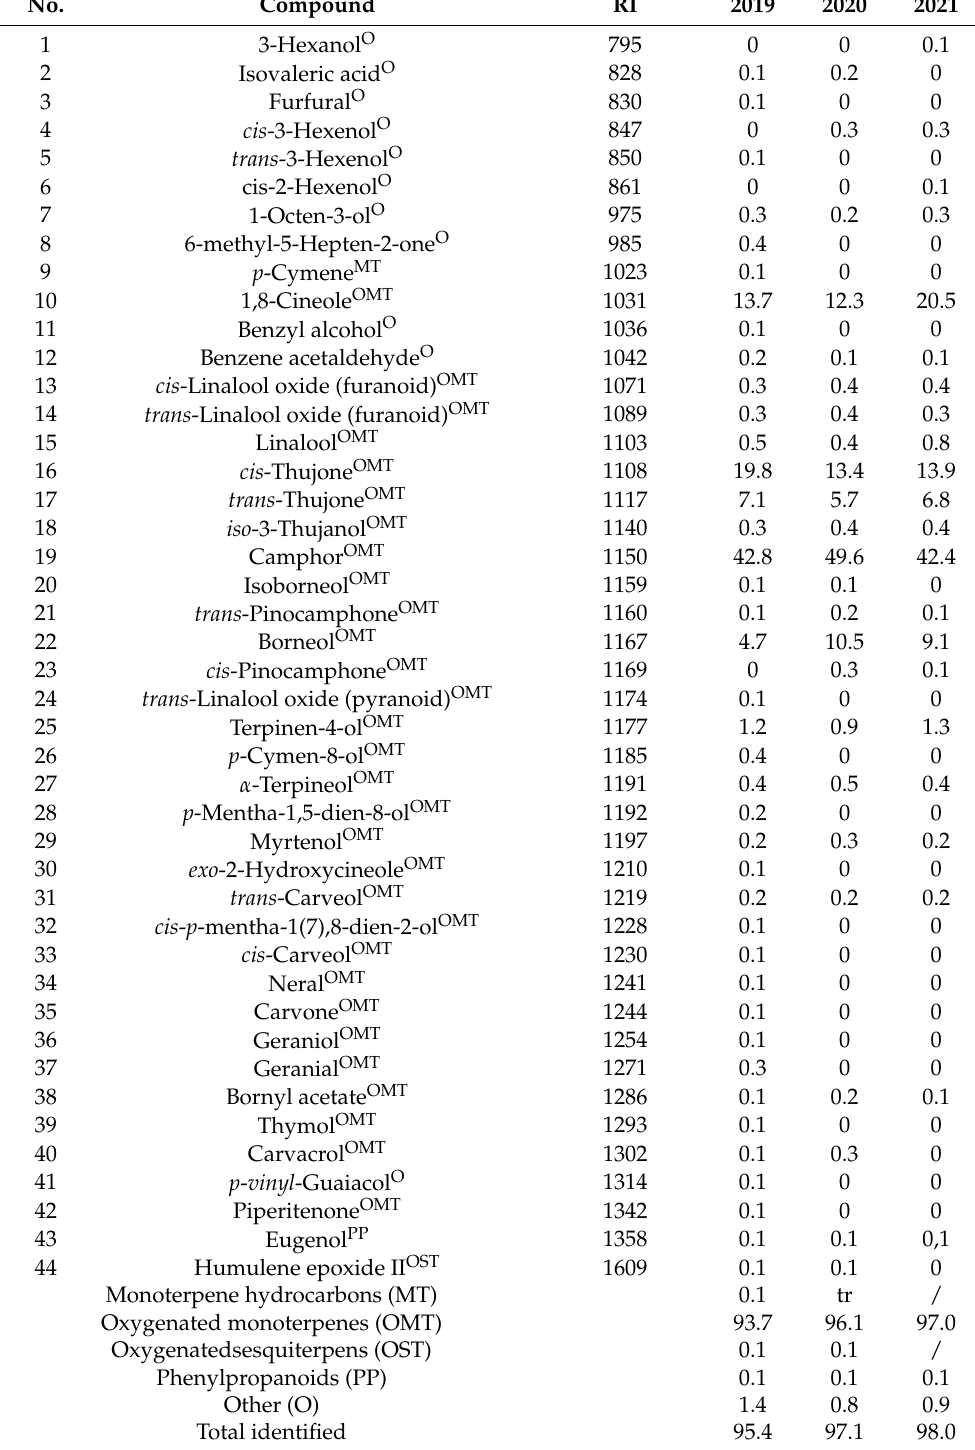
Table 5. Salvia officinalis hydrolate chemical